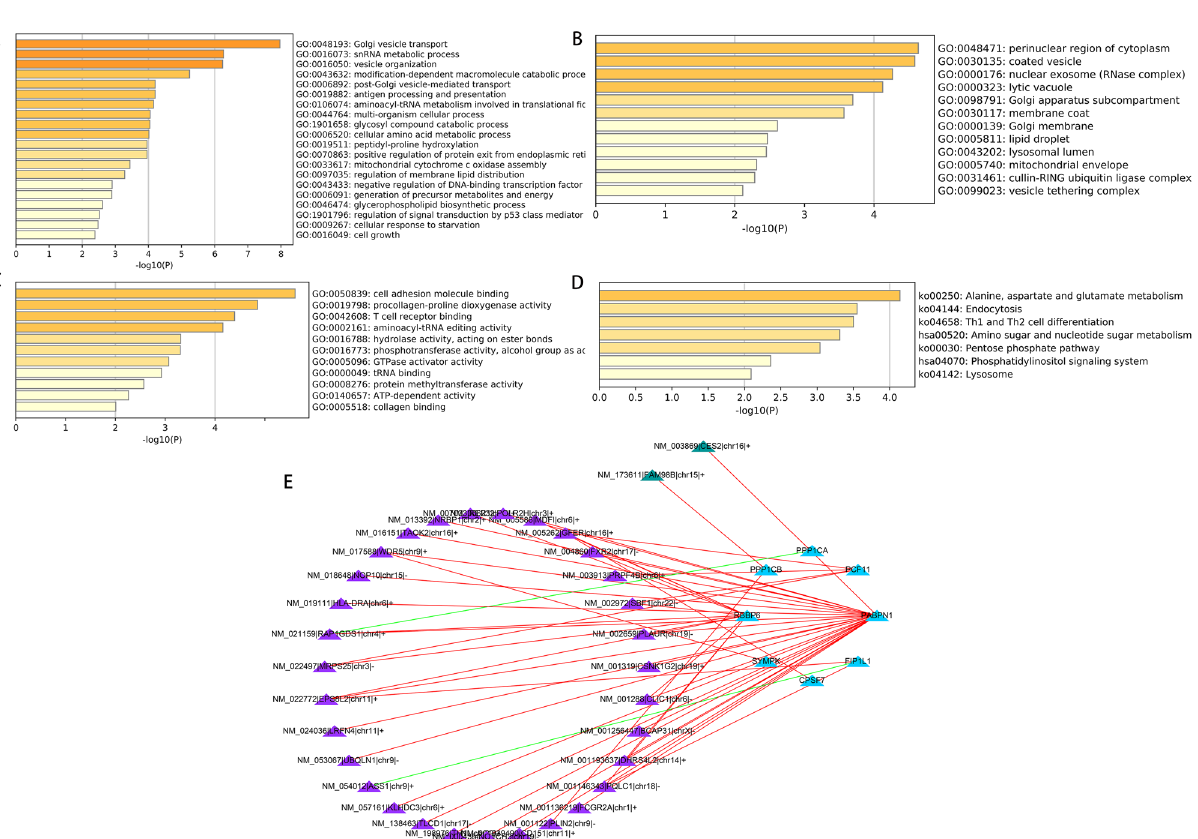
Figure 1. Enrichment analysis of the corresponding genes of prognosis-related APA events and Construction of a survival-associated. Volcano plot of prognosis-related APA events. An overview of the GO annotations of the prognostic APA in three categories: BP ( A ), CC ( B ) and MF ( C ). ( D ) KEGG pathway analysis. ( E ) CRs- APAs network (blue triangles, purple triangles and green triangles were CRs, poor prognosis events and good prognosis events, respectively. Red/green lines represent positive/negative correlations between